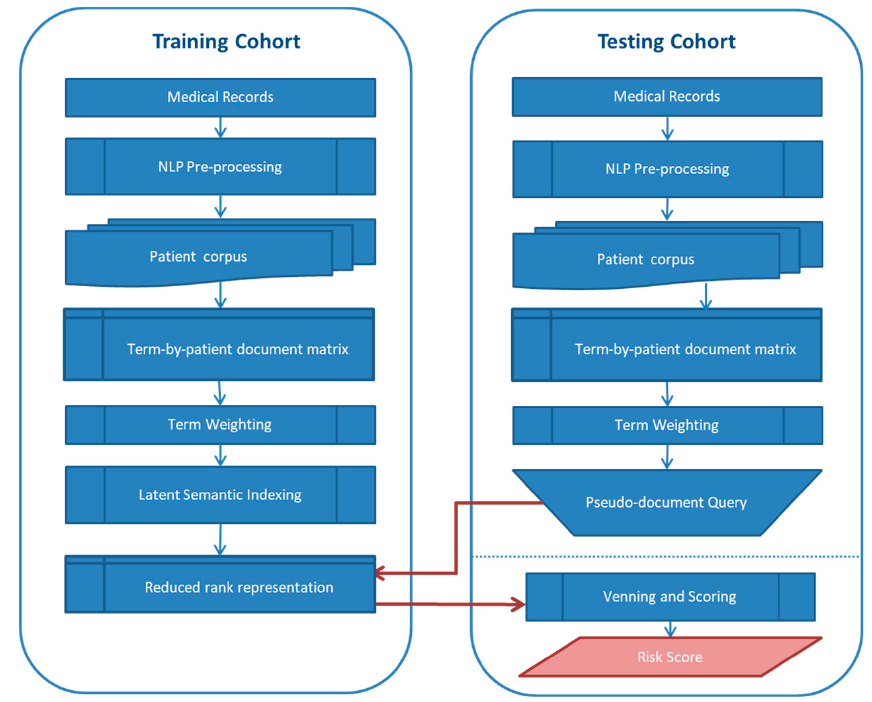
Figure 2 . Flow diagram for Quire Predictive Modeling (QPM) algorithm. Figure 2. Flow diagram for Quire Predictive Modeling (QPM)